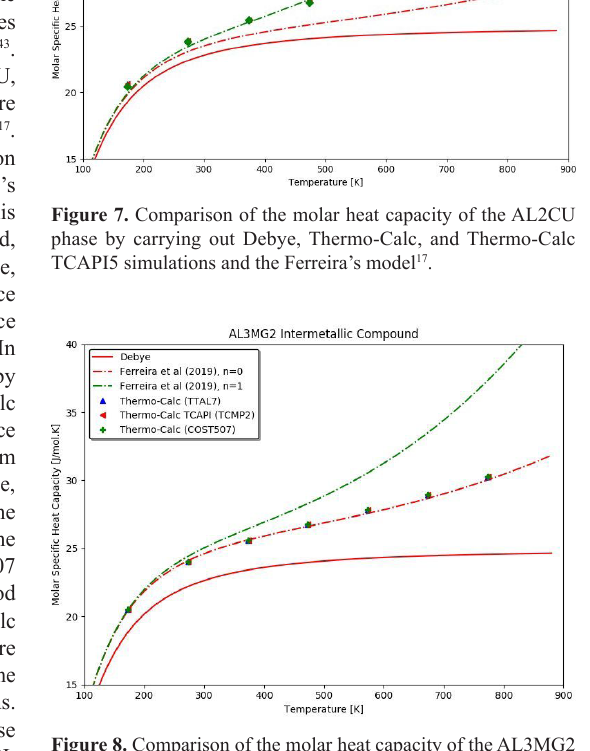
Figure 8. Comparison of the molar heat capacity of the AL3MG2 phase by carrying out Debye, Thermo-Calc, and Thermo-Calc TCAPI5 simulations and the Ferreira’s model 17